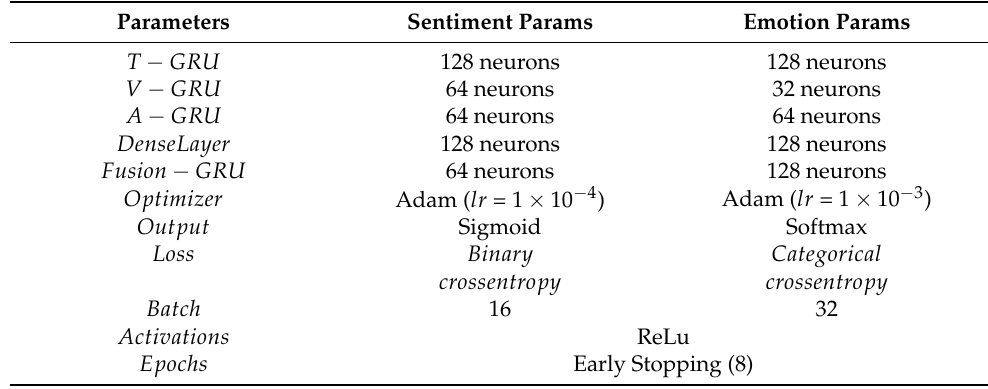
Table 2. Model configurations.